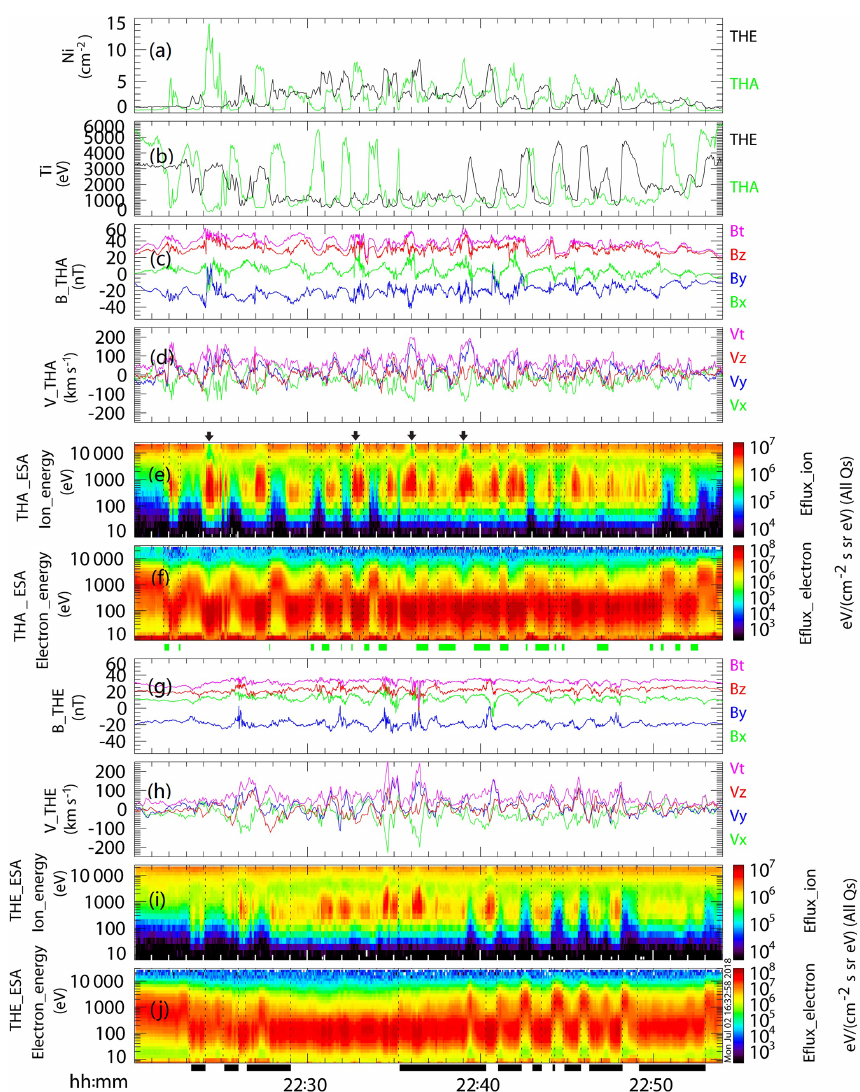
Figure 2. Fluctuations in the plasma parameters and the ion and electron energy–time spectra. Panel (a) is the ion densities from TH-A as a green line and from TH-E as a black line; panel (b) is the ion temperatures from TH-A as a green line and from TH-E as a black line; panels (c) and (d) are the magnetic field vectors and the ion bulk velocity vectors from TH-A, respectively; panels (e) and (f) are the ion and electron energy–time spectra from TH-A, respectively; panels (g) and (h) are the magnetic field vectors and the ion bulk velocity vectors from TH-E, respectively; panels (i) and (j) are the ion and electron energy–time spectra from TH-E, respectively. Vectors are all expressed in GSM coordinates. The four black arrows mark at the top of panel (e) the TH-A intervals in the magnetosheath. The green bars at the bottom of panel (e) and the black bars at the bottom of panel (i) mark the transport regions in TH-A and TH-E observations, respectively, identified based on the criteria dictated in the